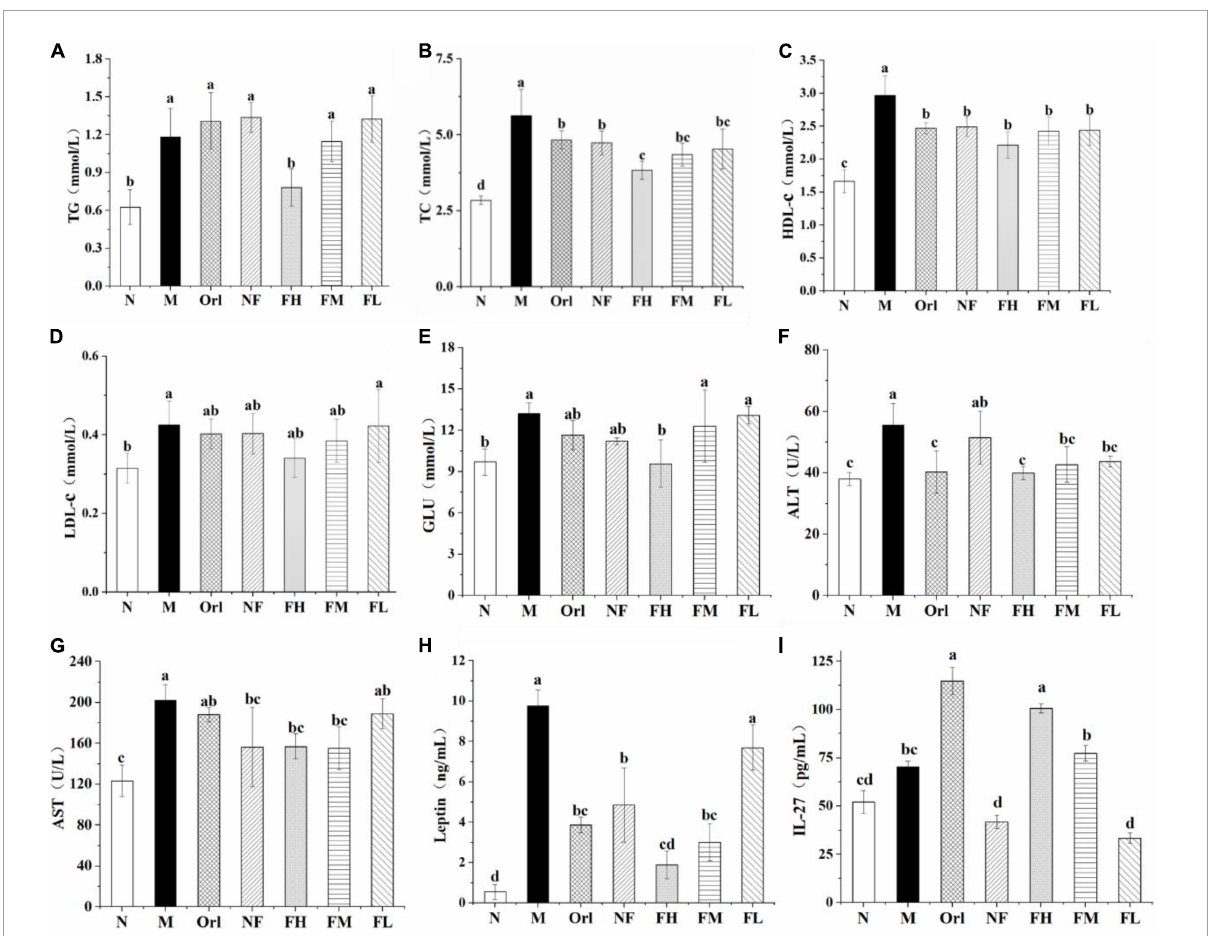
FIGURE3 Effects of FAK on serum levels of TG (A) ; TC (B) ; HDL-c (C) ; LDL-c (D) ; GLU (E) ; ALT (F) ; AST (G) ; leptin (H); and IL-27 (I) in mice. All data are expressed as mean ± SD ( n = 5). (a–d) Bands with different letters indicate significant differences ( P <